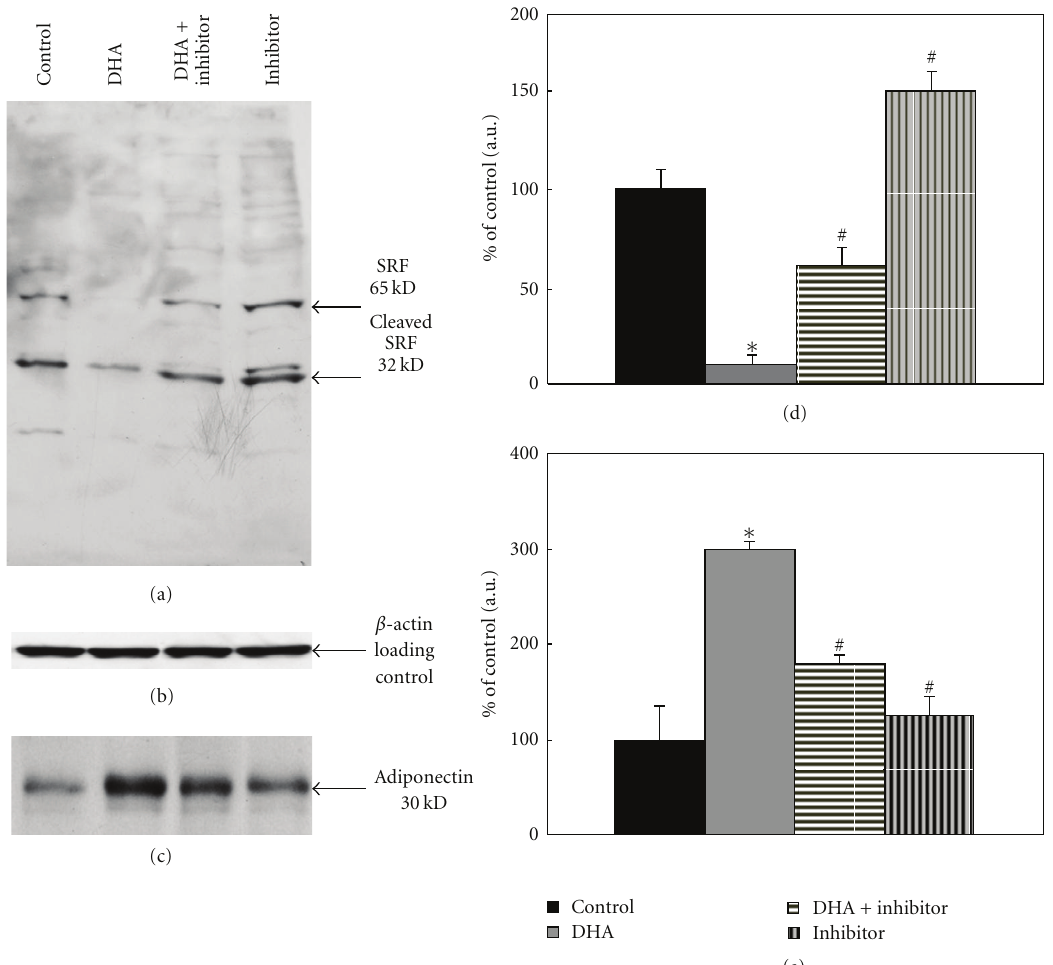
Figure 1: E ff ects of DHA on SRF and adiponectin in 3T3-F442A adipocytes. 3T3-F442A adipocytes di ff erentiated as described in Methods were treated with 25 μ M DHA, 25 μ M DHA plus 1.5 μ M GW9662 or 1.5 μ M GW9662 in DMEM containing 1% FBS for 16 h. Cells were lysed and separated on 10% SDS-PAGE followed by Western blotting with specific antibody. (a) Blots were analyzed with SRF C-terminus antibody. (d) Bar graph shows quantification using densitometric analysis of ≈ 65 kDa SRF protein. Data in the bar graph represents means of three independent experiments ( ∗ P < . 025, # P < . 05). (b) The same blot was analyzed with β -actin antibody to examine equal loading of proteins. (c) The same samples were also examined for the expression of adiponectin. Blots were probed with adiponectin antibody; bar graph shows quantitation of adiponectin protein using densitometric analysis and is expressed as percent of control. (e) Data in the bar graph represents means of three independent experiments ( ∗ P < . 05, # P < .